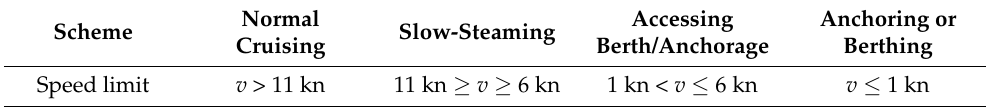
Table 7. Division of ship operation conditions.